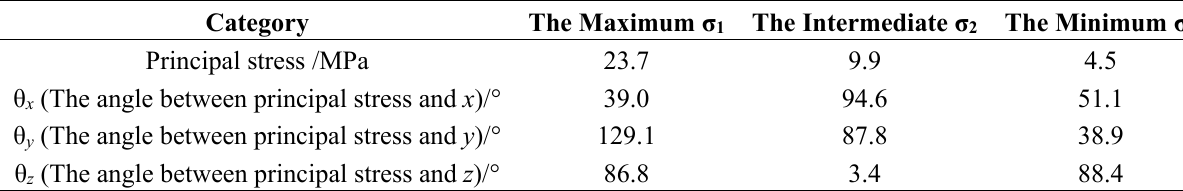
Table 3. Test result of in-situ